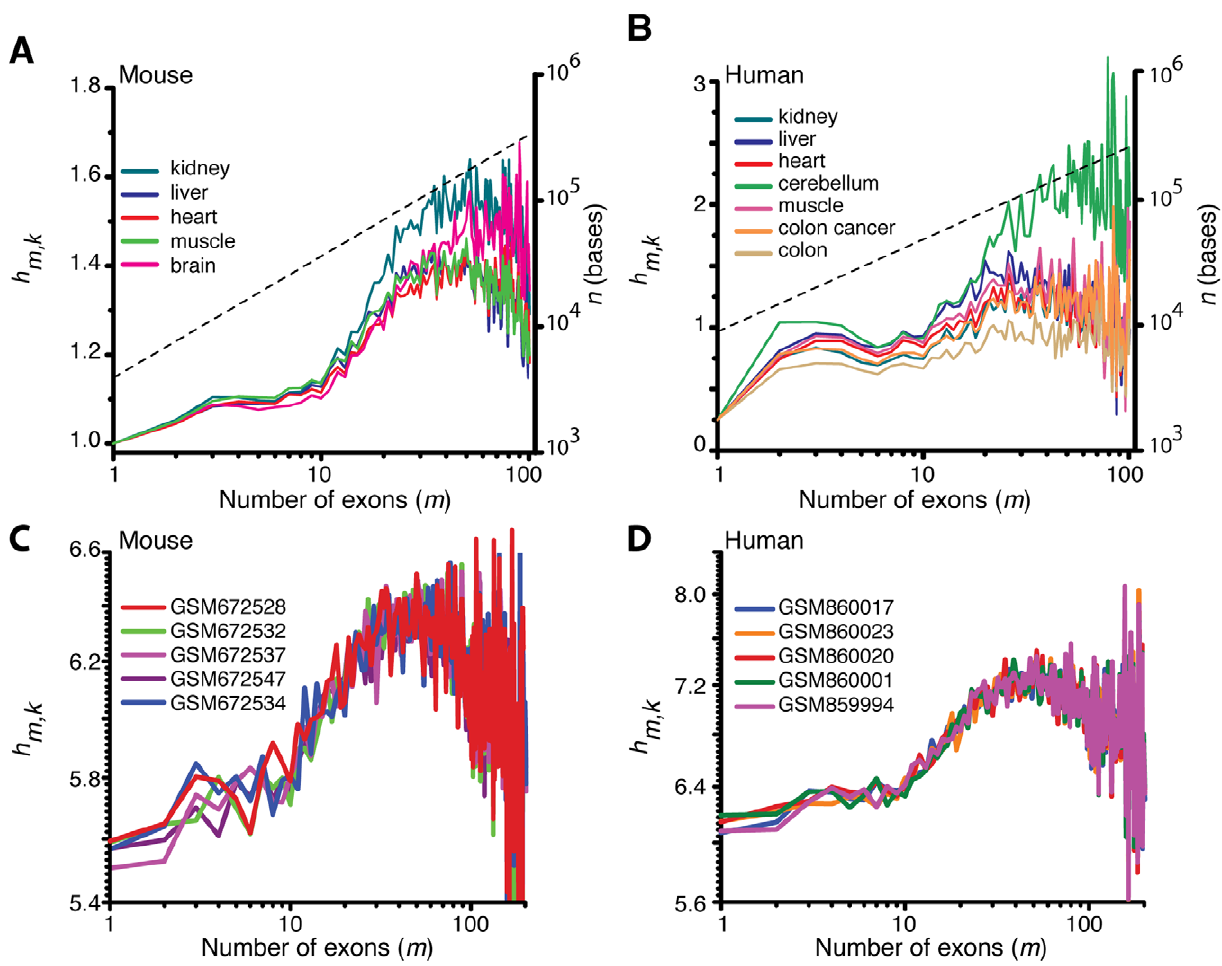
Figure 6. A–B. Genome-wide normalized average level of transcripts with m exons in the k th tissue ( h m,k , Eq. 16) in mouse (A) and human (B). Variation around these average signals is reported in Figure S4 . The data for this figure come from exon microarray experiments (Materials and Methods). These plots show a broad maximum approximately centered around m , 32 exons (arrow). The dashed line shows the approximate average exon position in base pairs on the secondary y axis. C–D . Genome-wide normalized average level of transcripts with m exons in the k th tissue ( h m,k , Eq. 16 ) in human ( C ) and mouse ( D ). The data for this figure come from RNAseq experiments (Materials and Methods) (cf. data in Figure 6 from microarray